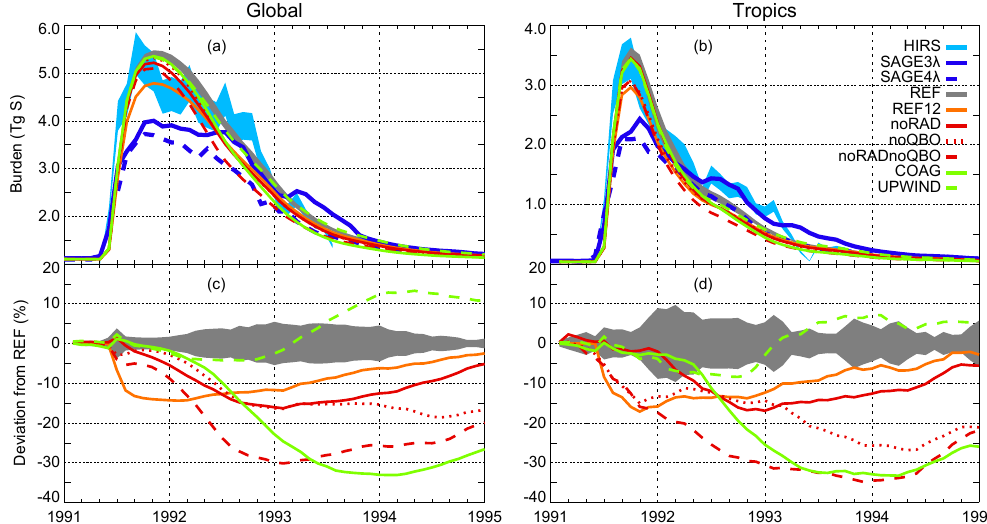
Figure 1. (a, b) Evolution of model-calculated global (pole to pole, left) and tropical (20 ◦ S–20 ◦ N, right) stratospheric aerosol burden (Tg of S) compared with the HIRS- and SAGE-II-derived data (SAGE-3,4 λ ). HIRS-derived aerosol sulfur burden assumes 75% sulfuric acid by weight. Light blue shaded area: uncertainties of HIRS. Grey shaded area: 2 σ ensemble spread of the REF experiment. All other experiments are shown as ensemble means. (c, d) Same as (a) and (b) , but deviations of all the numerical experiments from the REF in